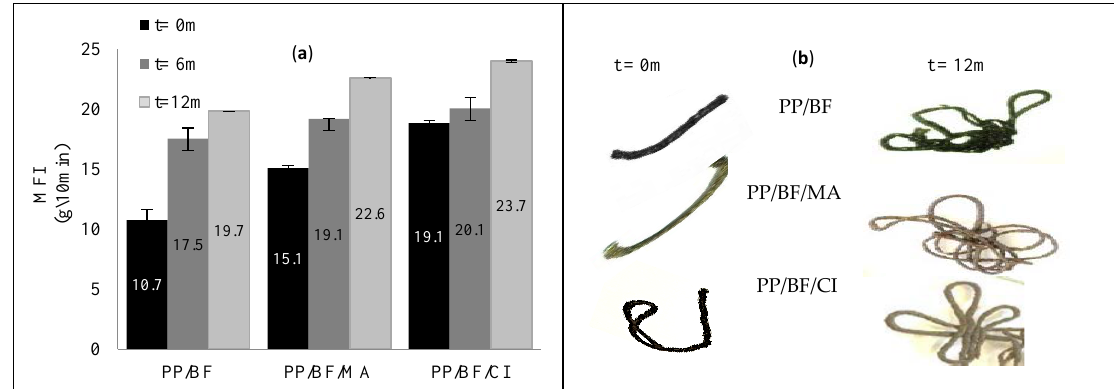
Figure 8. Results of melt flow index (MFI) of composites: ( a ) before and after 6 and 12 months natural aging; ( b ) pictures of samples tested by MFI before and after 12 months exposure.